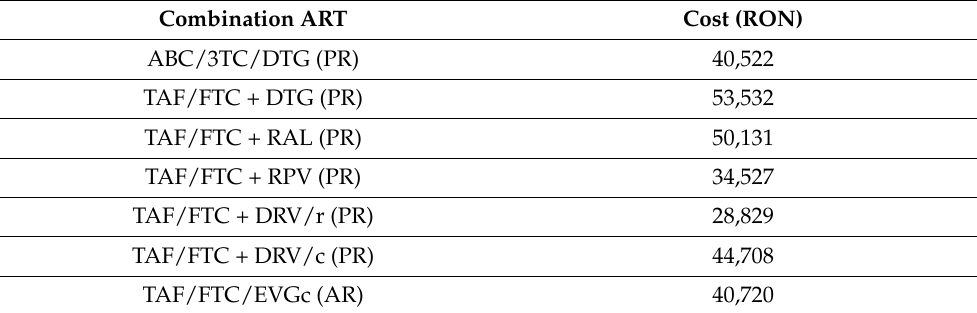
Table 1. Cost (RON) for initiation and treatment of up to 48 weeks with each regimen.